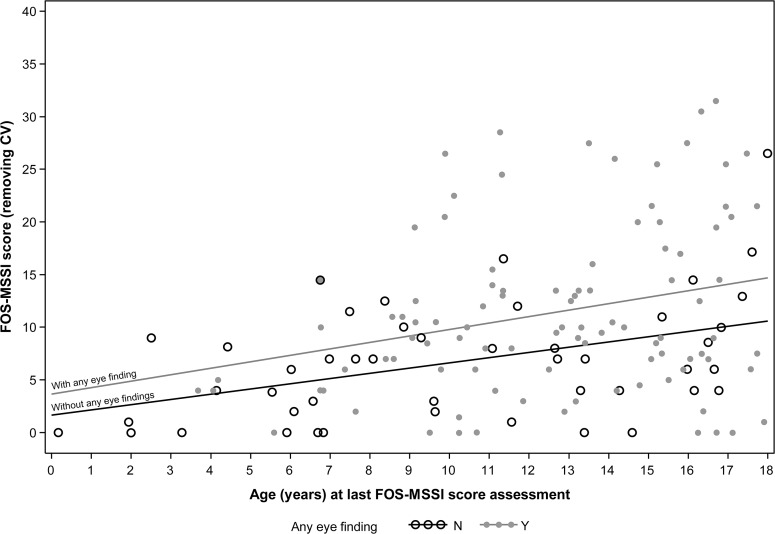
Relationship between disease severity and age in children with and without any eye findings.Scatter plot of FOS-MSSI score versus age (in years) at last FOS-MSSI score assessment, showing regression (trend) lines* for children with and without any eye findings. Children with eye findings (solid grey dots) had more severe disease across all ages than children without any eye findings (open black circles). Disease severity increased with age in both children with and without eye findings. CV = cornea verticillata; FOS-MSSI = Fabry Outcome Survey Mainz severity score index. *Regression lines were determined by the following equations: 1. With any eye findings: FOS-MSSI (removing cornea verticillata) = 3.638976 + 0.613467 × age at FOS-MSSI assessment. 2. Without any eye findings: FOS-MSSI (removing cornea verticillata) = 1.646037 + 0.497238 × age at FOS-MSSI assessment.